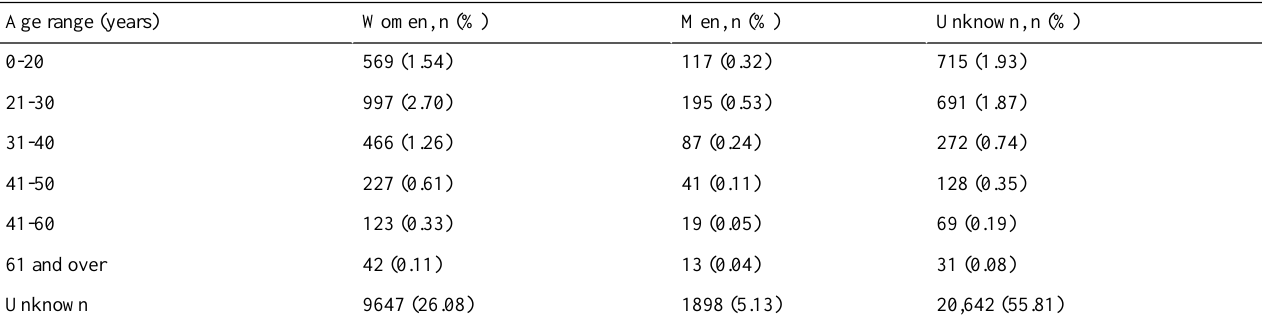
Table 3. Users’characteristics: number of web users and relative number of web users (among 36,989